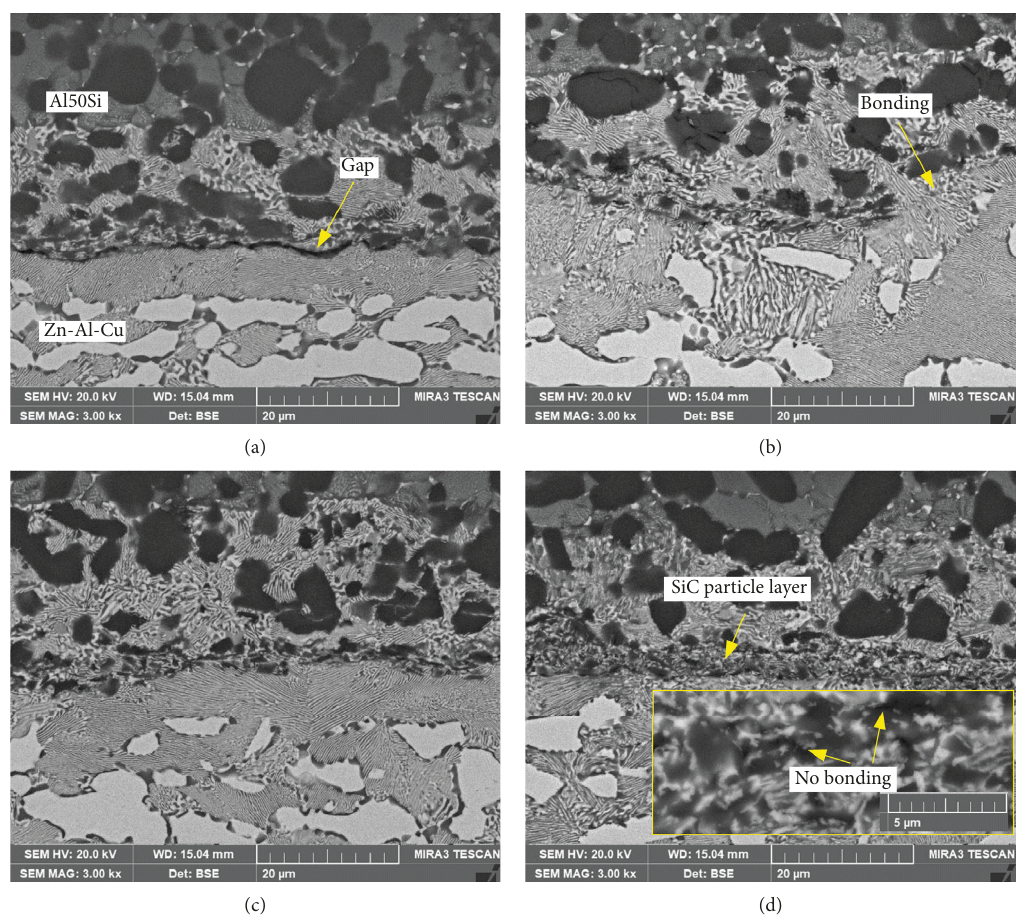
Figure 3: Interfacial microstructure of the joint with 1 μ m SiC particles at (a) 1 g/m 2 , (b) 2g/m 2 , (c) 3g/m 2 , and (d) 4 g/m 2